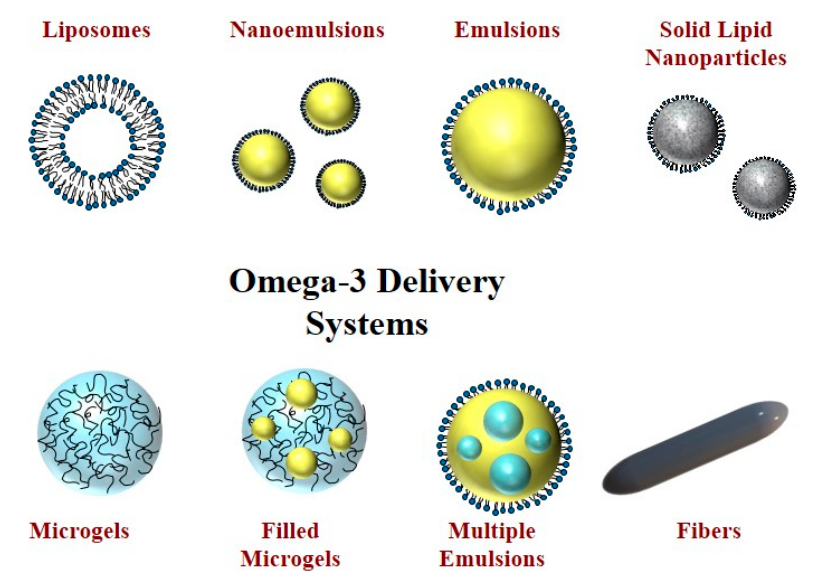
Figure 3. Examples of colloidal systems that can be used to encapsulate, protect, and deliver omega-3 PUFAs.